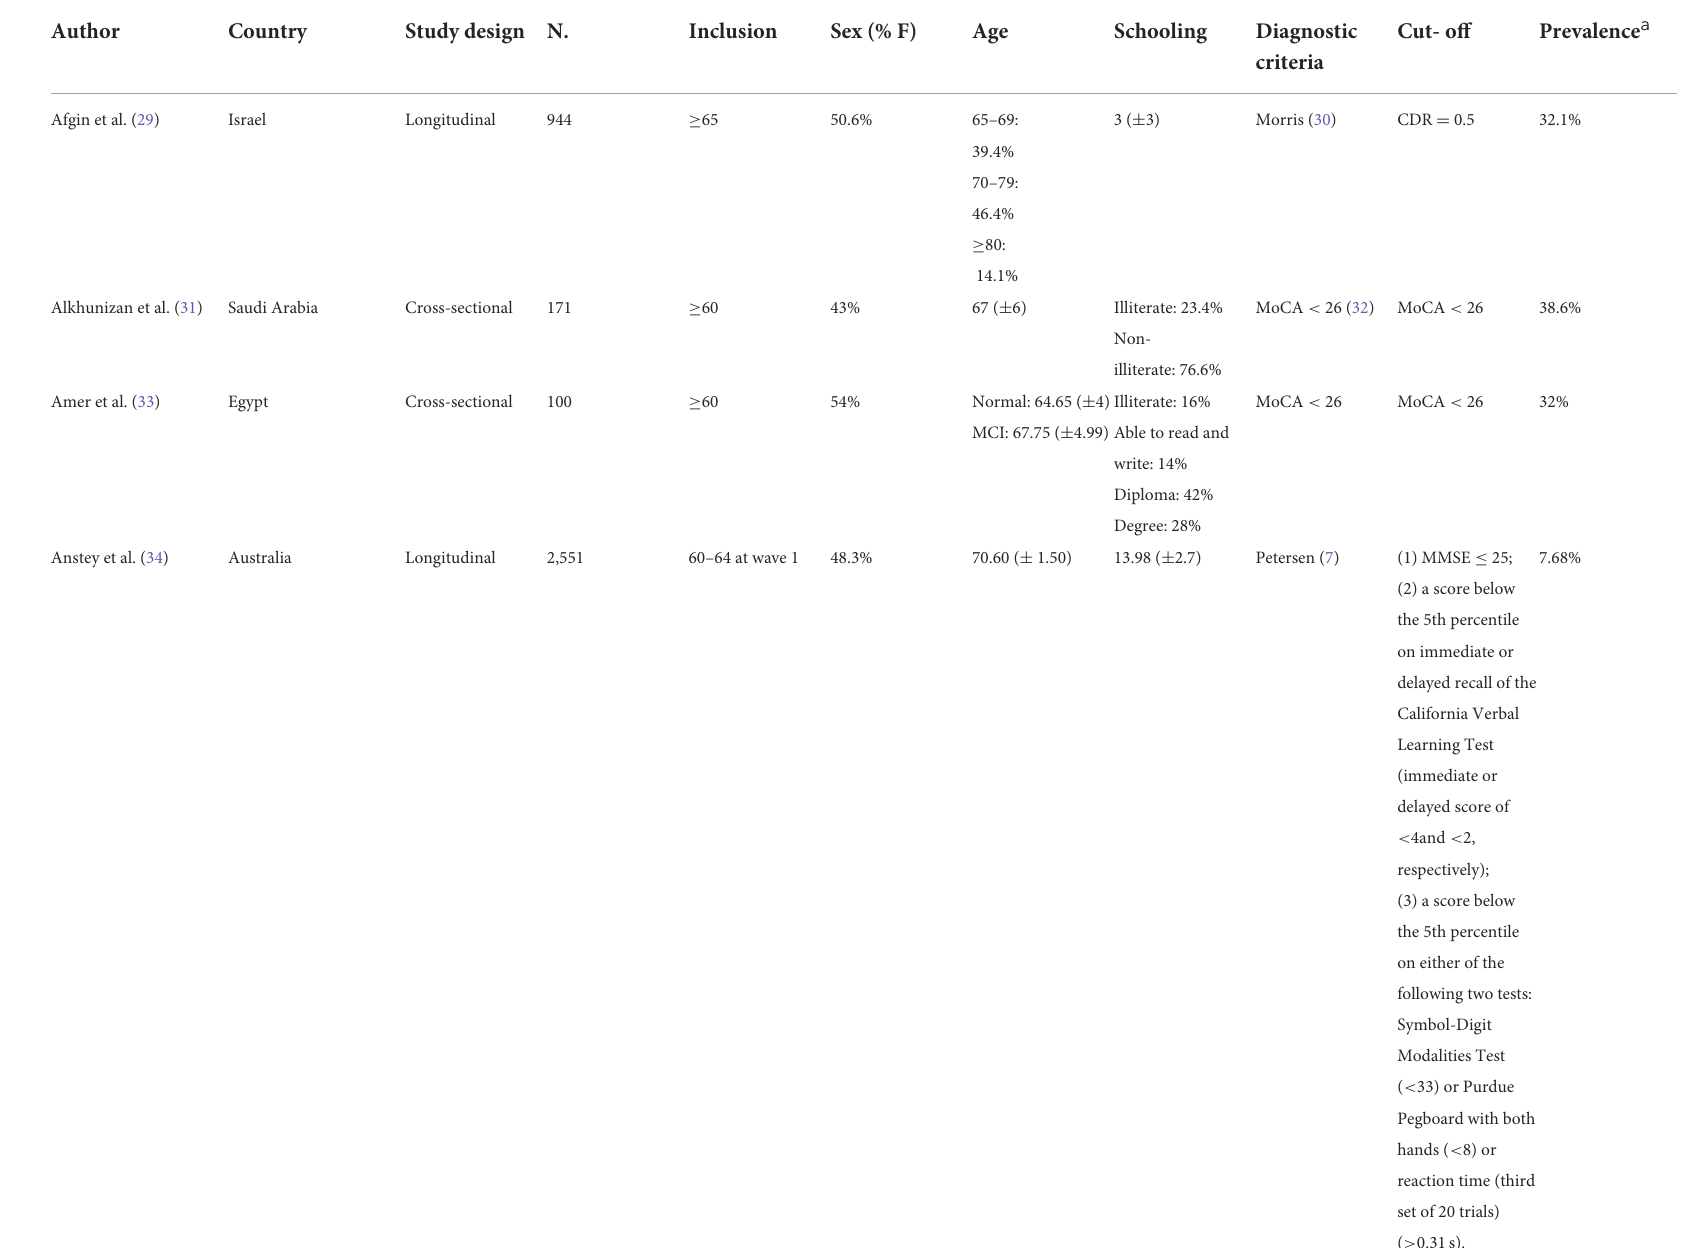
TABLE 3 Selected studies’ characteristics and MCI